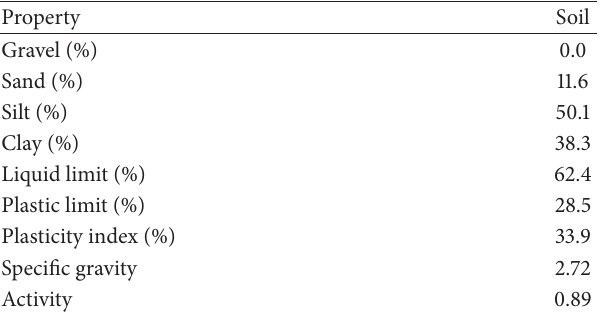
Table 1: Physical characteristics and Atterberg limits of the consid- ered soil.